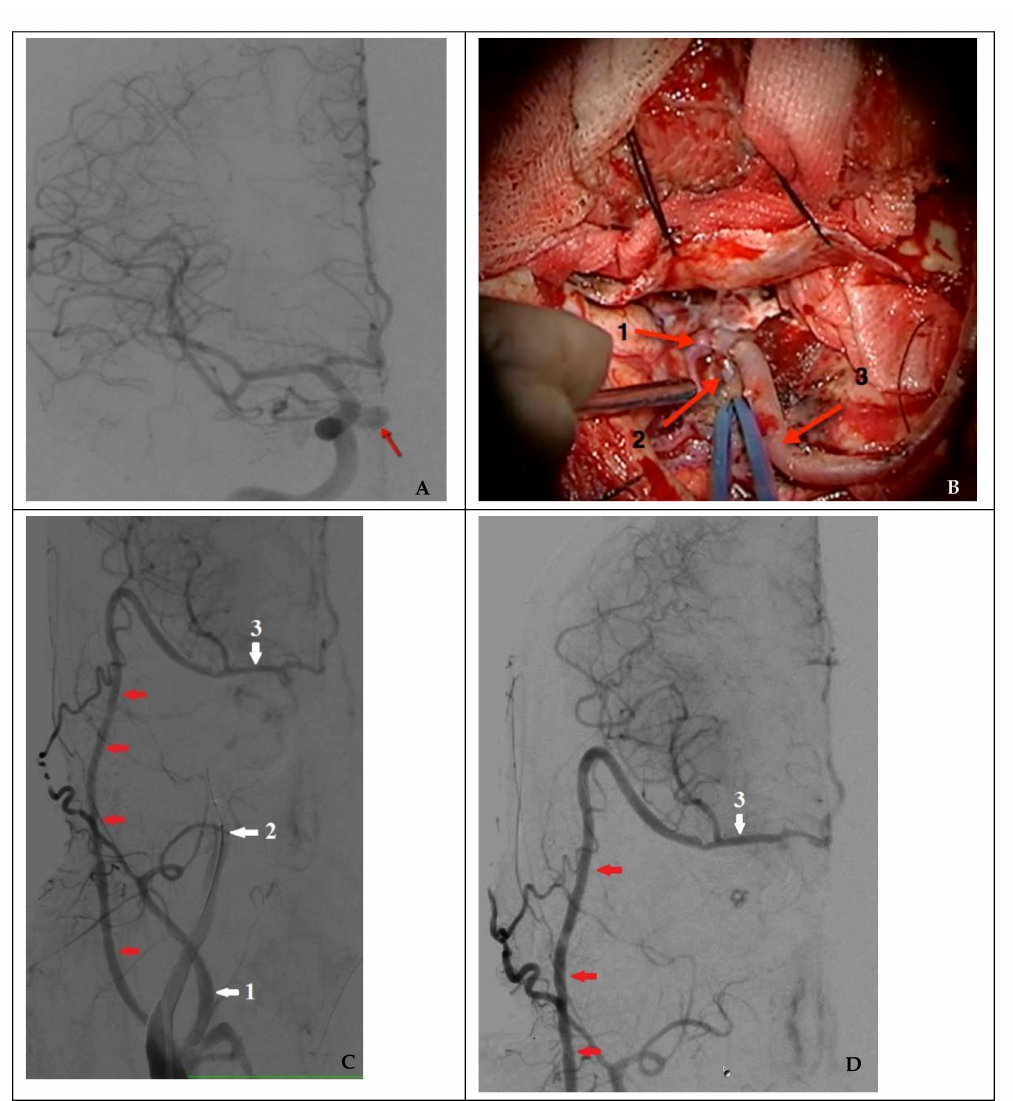
Figure 5. Combined treatment in a case of nonsufficient circulation (clinical case 8). ( A ) Angiography of the right ICA (the arrow indicates a false aneurysm), ( B ) view of a high-flow bypass with right MCA M2 segment bifurcation (1: frontal branch of M2; 2: distal sections of the temporal branch of M2; and 3: radial artery as the graft), ( C ) functioning high-flow bypass (indicated by red arrows) during a temporary test ICA occlusion, and ( D ) control angiography after endovascular occlusion of a false aneurysm and the injured right ICA (1: external carotid artery; 2: internal carotid artery occluded by a balloon; and 3: middle cerebral